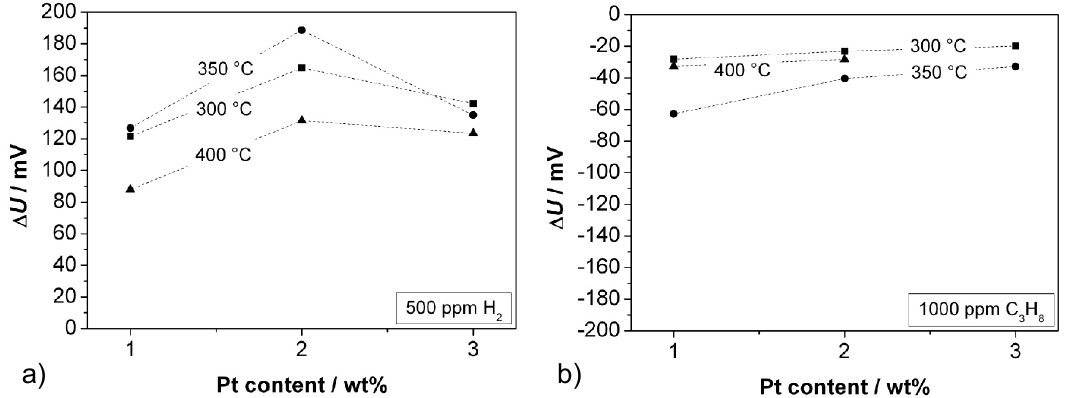
Figure 6. Sensor output change Δ U for differently platinum-loaded zeolites when exposed to (a) 500 ppm H and to (b) 1,000 ppm C 2